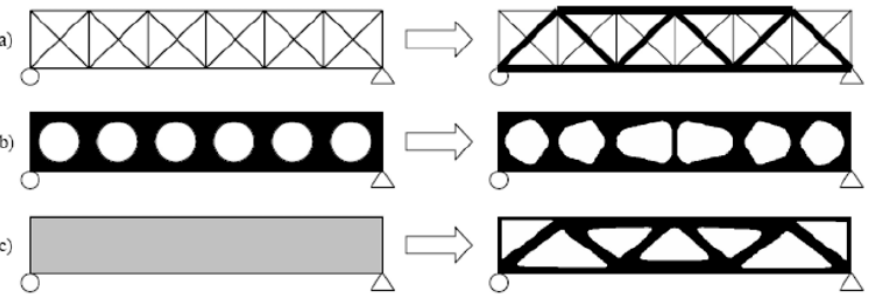
Figure 3. Simple beam parametric optimization ( a ) of shape ( b ) and topology ( c ). Adapted from [1].